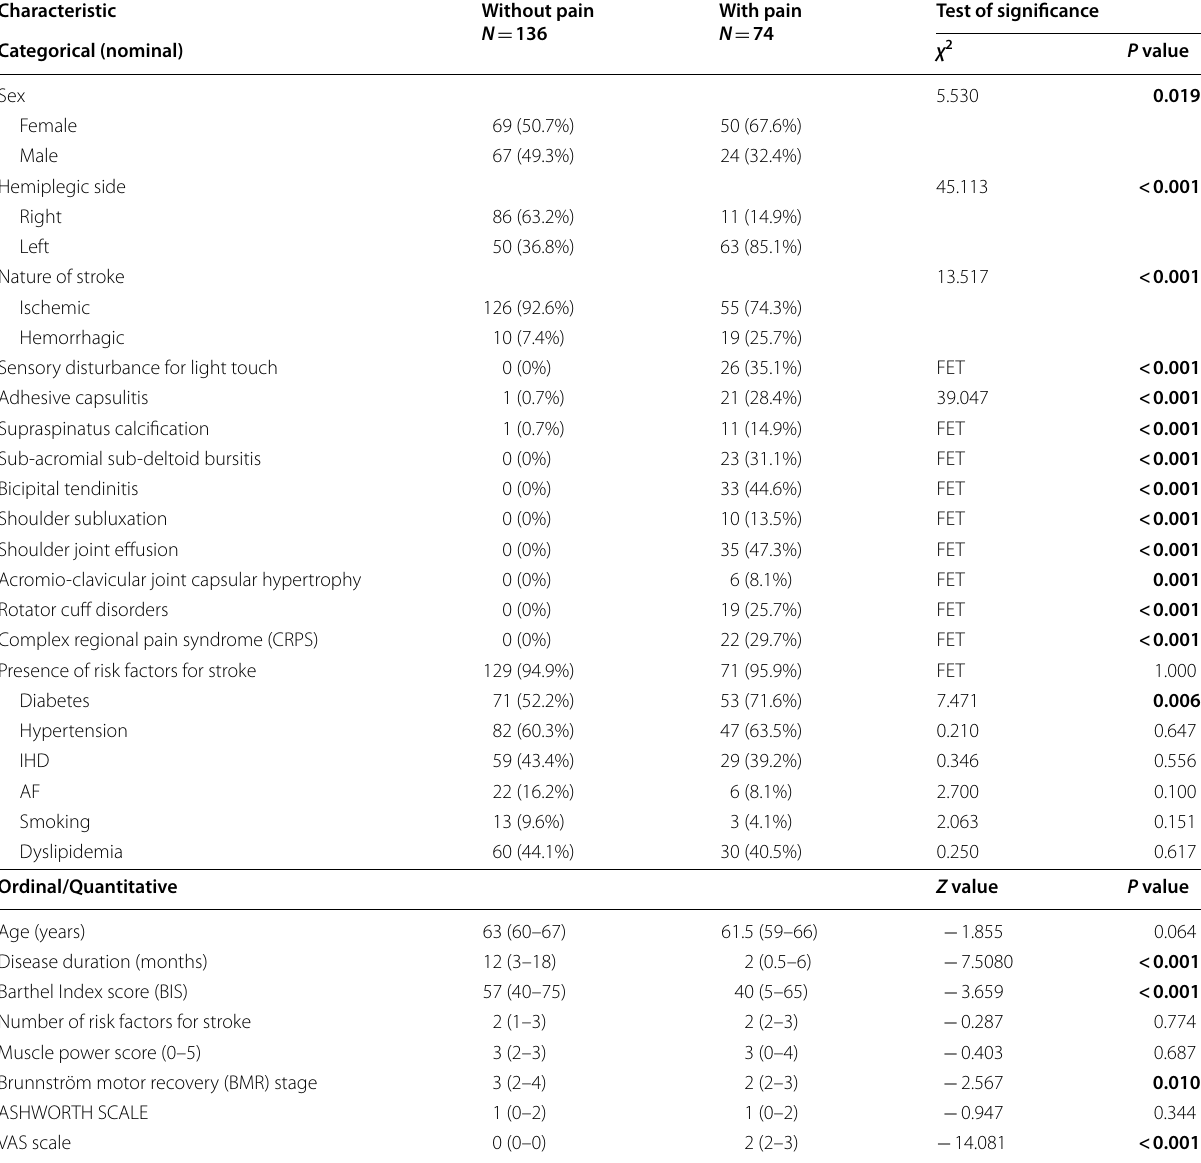
Bold indicates that p value